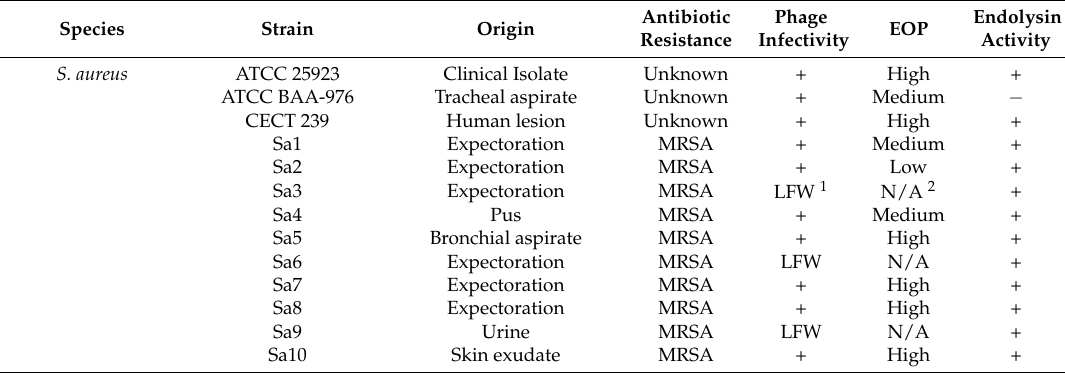
Table 1. Phage vB_SauM-LM12 (LM12) spectrum of activity with efficiency of plating (EOP) and E-LM12 lytic spectrum. High, moderate, and low efficiency of plating represent >10%, 0.01–9%, and <0.01%,